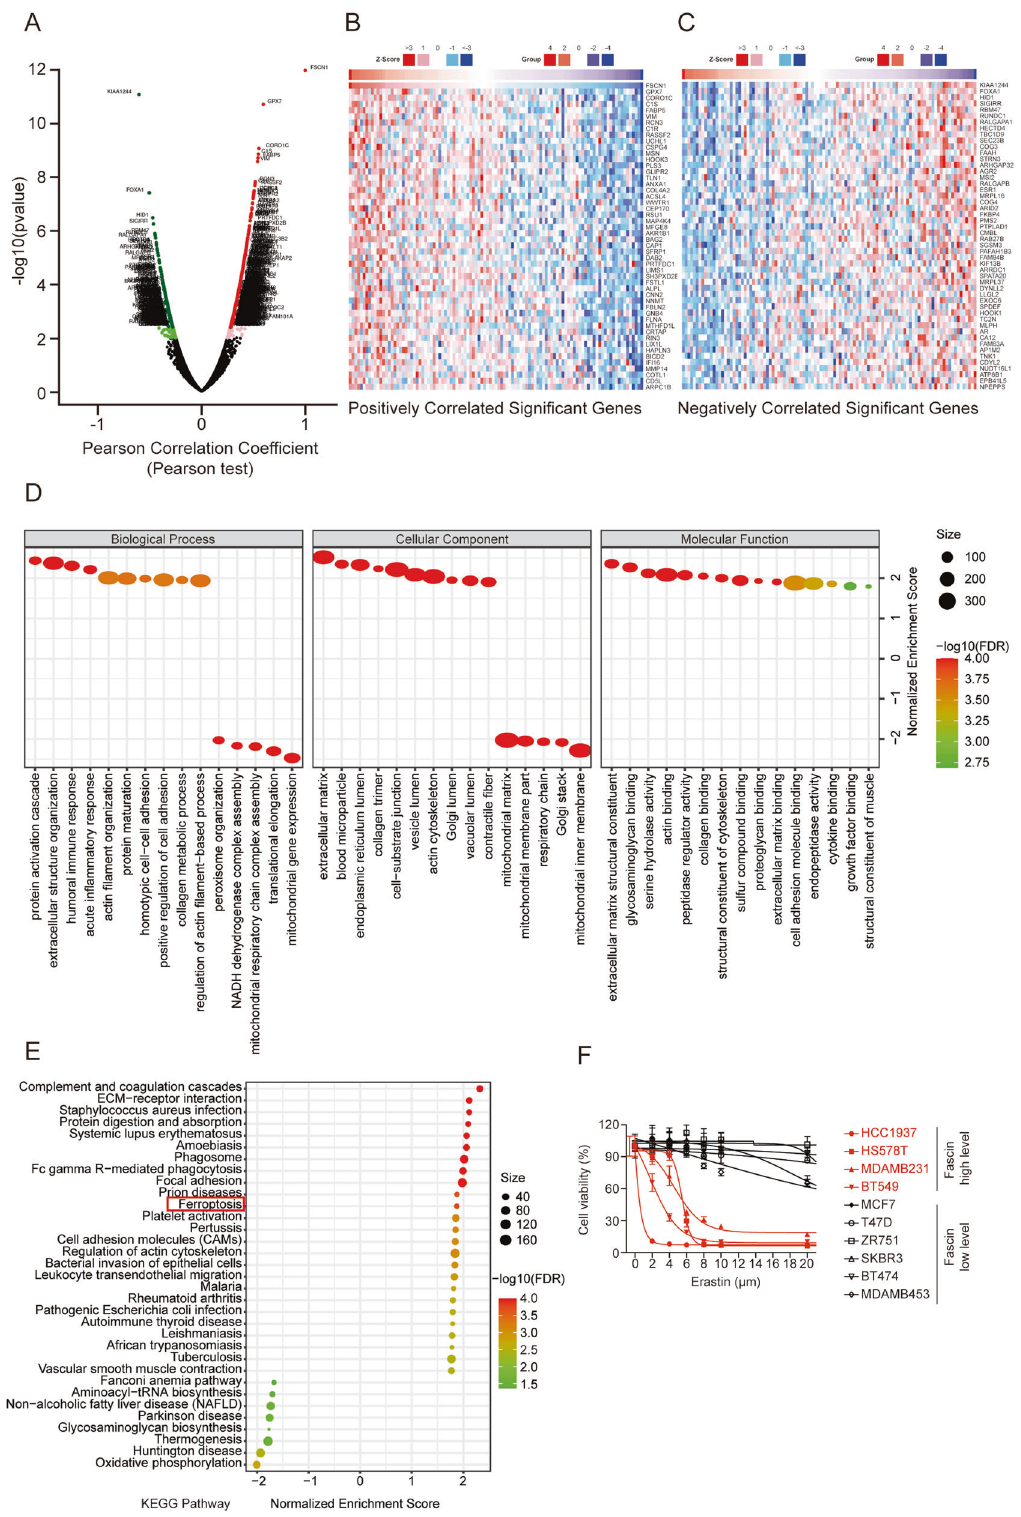
Fig. 2 Identi fi cation of proteins co-expressed with Fascin in breast cancer using the LinkedOmics database. A The volcano plot of Fascin co-expression proteins. Heat maps showing the top 50 proteins positively ( B ) and negatively ( C ) correlated with Fascin. The GO annotation ( D ) and KEGG pathway ( E ) enrichment of proteins co-expressed with Fascin in breast cancer were analyzed using Gene Set Enrichment Analysis (GSEA). F Breast cancer cell lines were incubated with the indicated concentrations of erastin for 48 h and then assayed for cell viability. The data are displayed as the means ± s.d of three independent